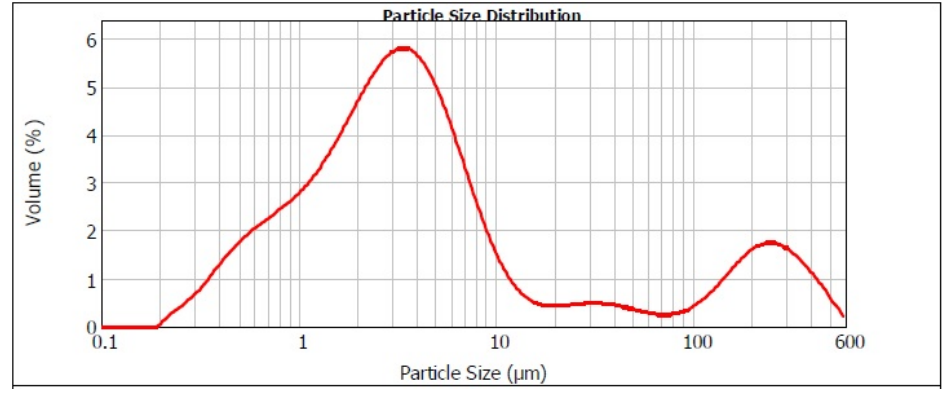
Figure 1. Distribution of particle sizes in our converter dust.